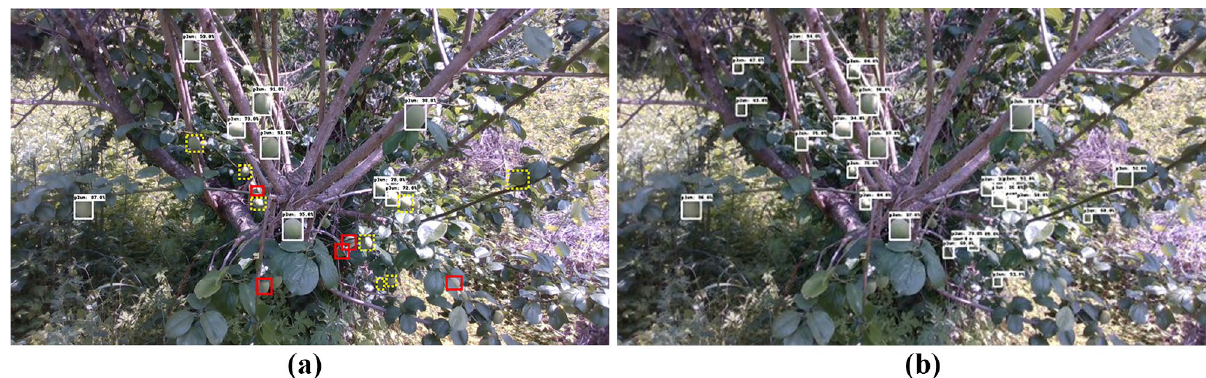
Figure 4. Detection results of same prunus mume image: ( a ) Before applying cropping method; ( b ) After applying cropping method (640 ×